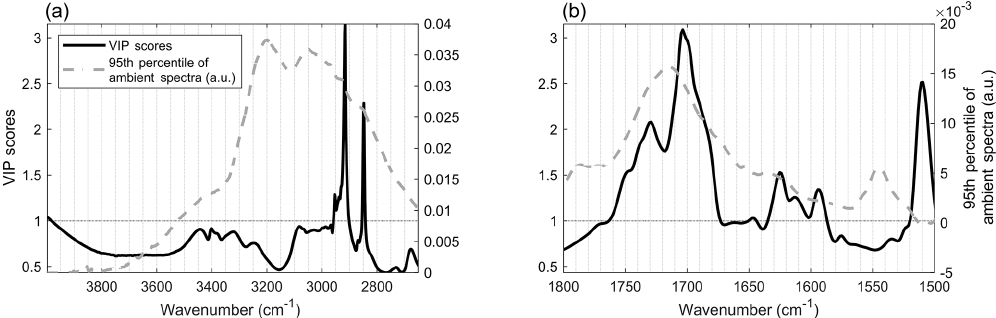
Figure 2. Variable importance in the projection (VIP) scores generated from the calibration models, as a weighted sum of the functional groups (Sect. S12, for calculation). An ambient spectrum is superimposed for comparison (95th percentile of all ambient